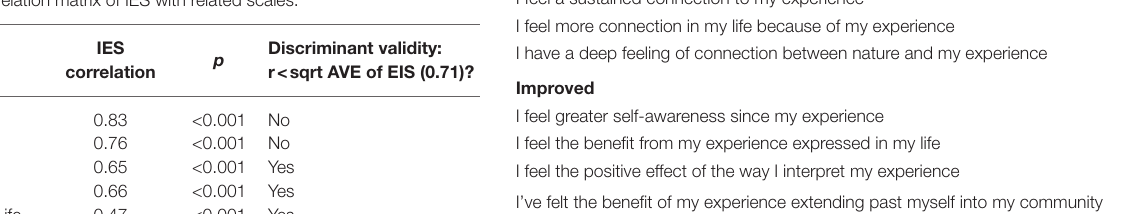
TABLE 11 | Correlation matrix of IES with related scales.